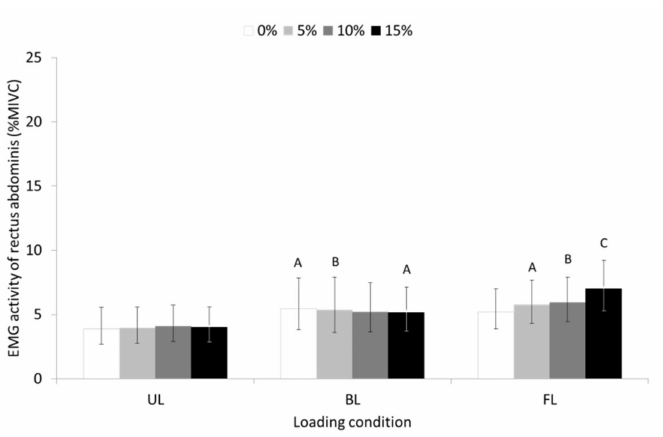
Figure 5. Geometric means and 95% confidence intervals (error bars) for the EMG activity of rectus abdominis during unloaded (UL), back-loaded (BL), and front-loaded (FL) walking at 0 (level), 5, 10, and 15% uphill slope. A SD compared to UL condition ( p ≤ 0.05); B SD compared to UL condition ( p ≤ 0.01); C SD compared to UL condition ( p ≤